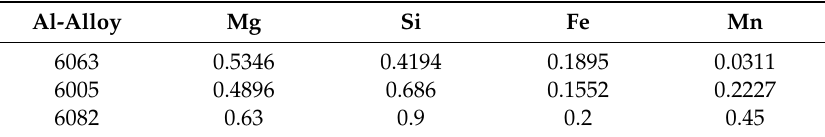
Table 1. Alloy compositions (wt%). Al is balance composition.